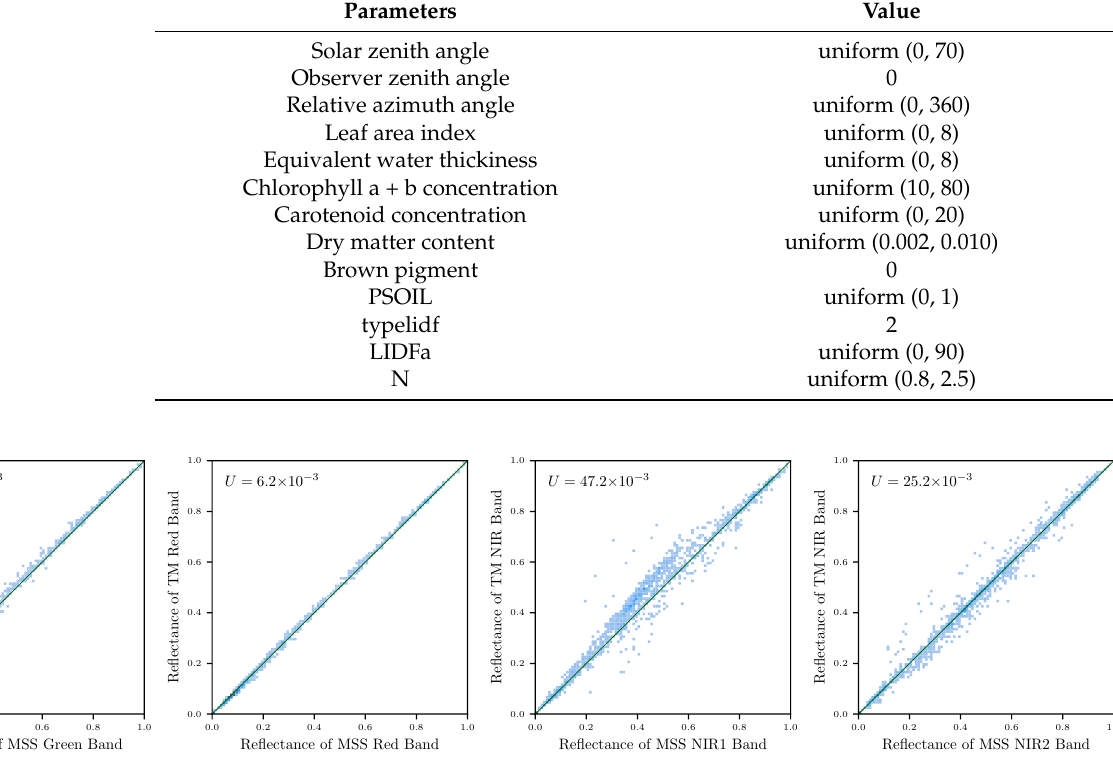
Table 3. Inputs of the PROSAIL model.